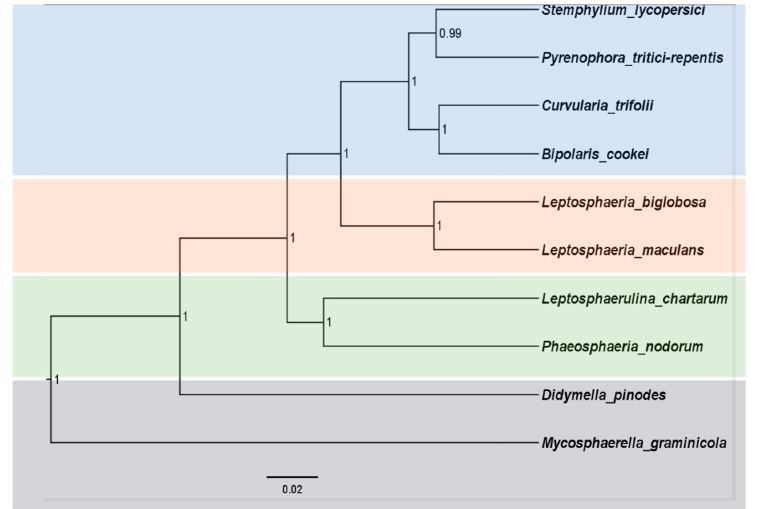
Figure 6. Phylogenetic analyses for combined nuclear DNA datasets. A combined dataset consisting of the seven nuclear genes ( TEF1 , RPB1, RPB2 , BT2 , β -actin, GAPDH , ITS were used to construct this phylogenetic tree.